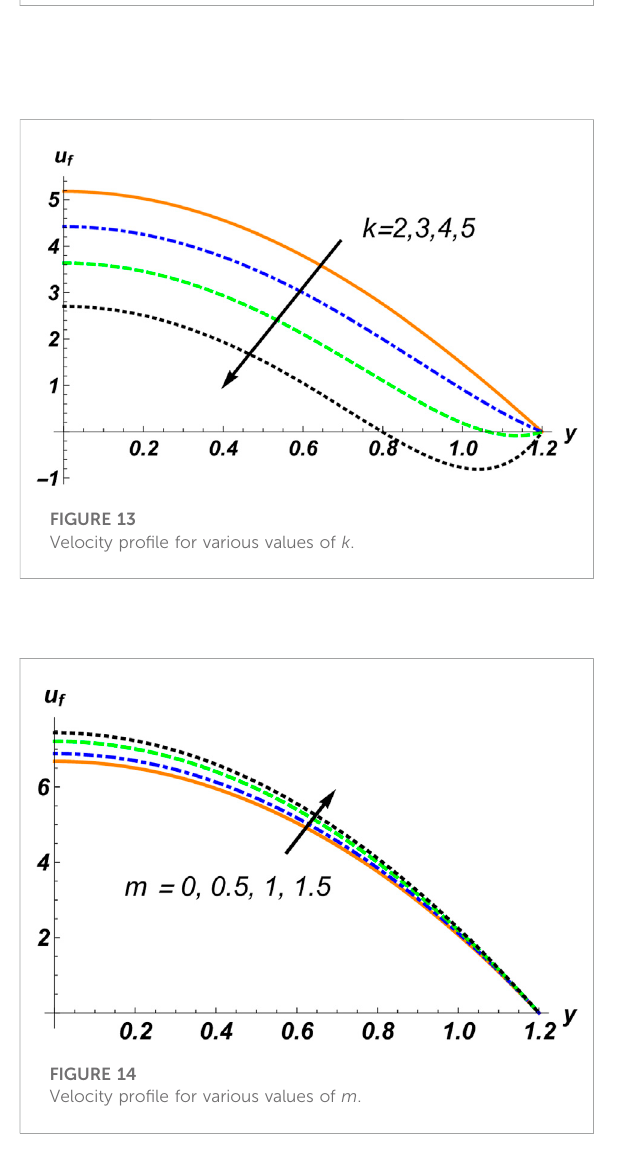
FIGURE 15 Velocity pro fi le for various values of Ue